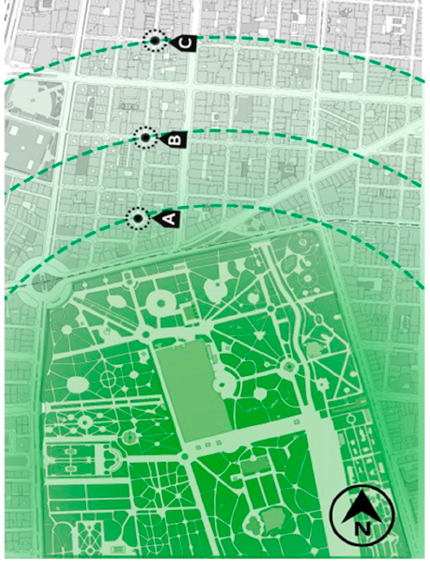
Figure 2. The northern region map of Retiro Park and the location of the selected sites. Point A is located 150 meters away from the park; point B is located 380 meters away from the park and point C is located 665 m away from the park.